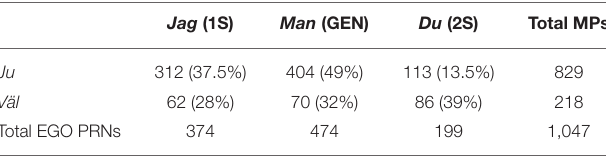
TABLE 1 | Relativized comparison between jag/man/du and ju/väl (after Bergqvist, 2020, p. 490) a